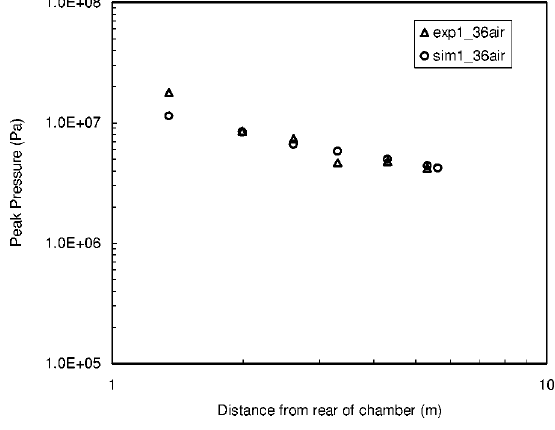
Fig. 5. Comparison between experiment and computation for 1.36 kg C4 charge detonation in air. good agreement, within 15% difference with the exper- imental data.